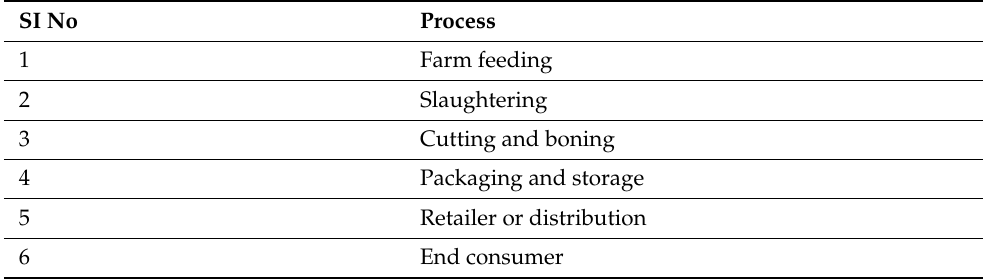
Table 3. Beef supply chain process or stages